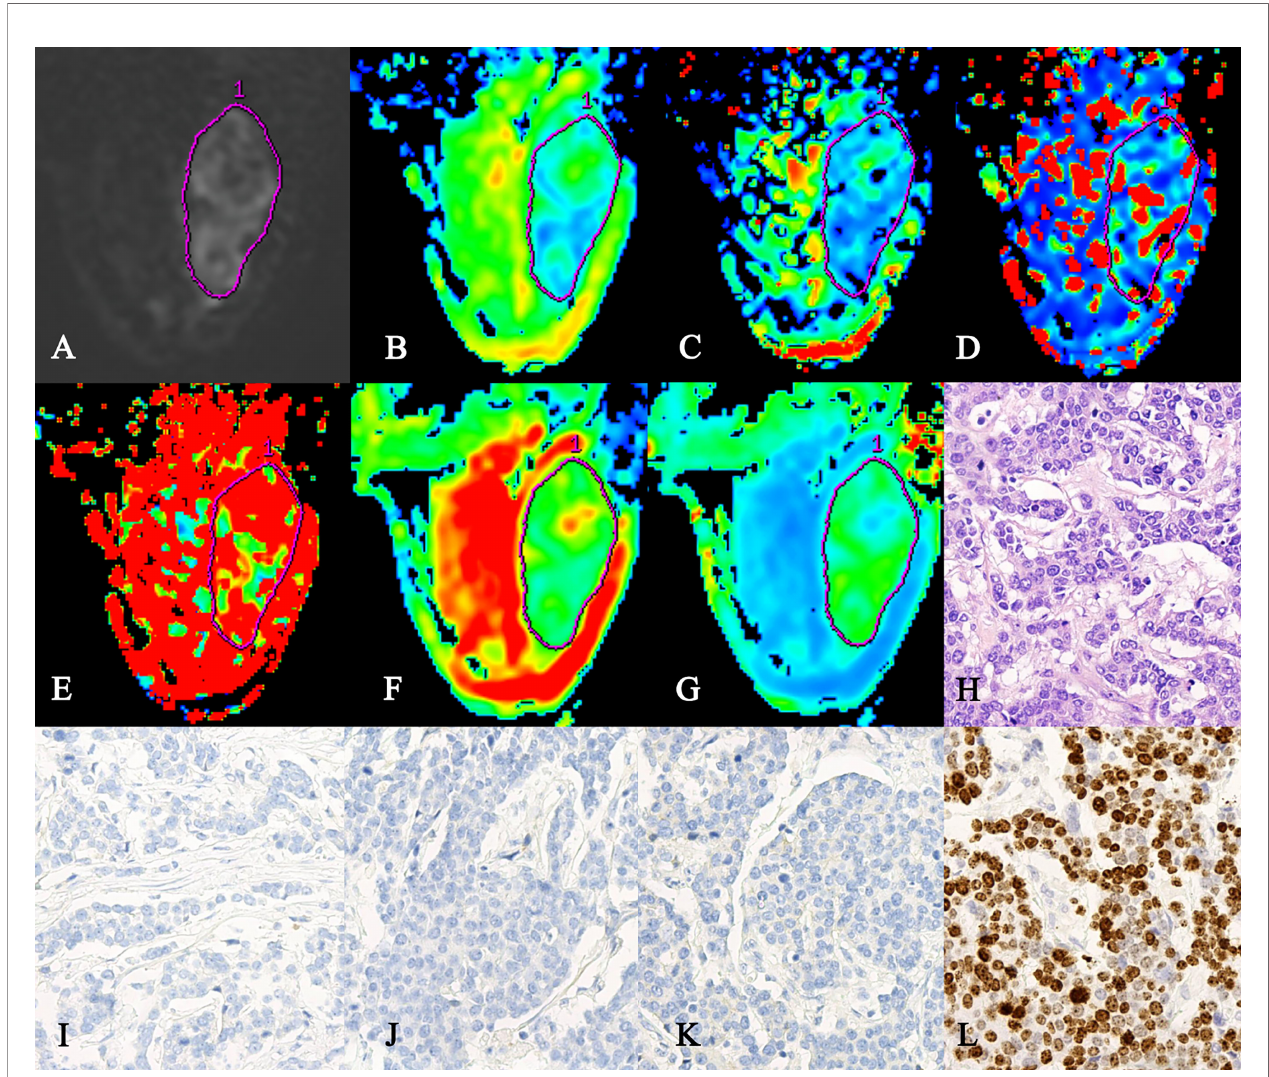
FIGURE 2 | A 47-year-old female patient with triple-negative cancer in the right breast. (A) ROI was set on the grayscale map with b-value of 1,000 s/mm 2 . (B – G) The pseudo-colored maps of the ADC, D, D*, f, MD, and MK. ADC = 1.05 × 10 − 3 mm 2 /s, D = 0.92 × 10 − 3 mm 2 /s, D* = 41.8 × 10 − 3 mm 2 /s, f = 81.1%, MD = 2.58 × 10 − 3 mm 2 /s, and MK = 0.774. (H) H&E staining of the invasive breast ductal carcinoma (×200). (I – L) Immunohistochemistry staining for the ER (I) , PR (J) , HER-2 (K) , and Ki-67 (L) in the invasive breast ductal carcinoma. ROI, region of interest; ER, estrogen receptor; PR, progesterone